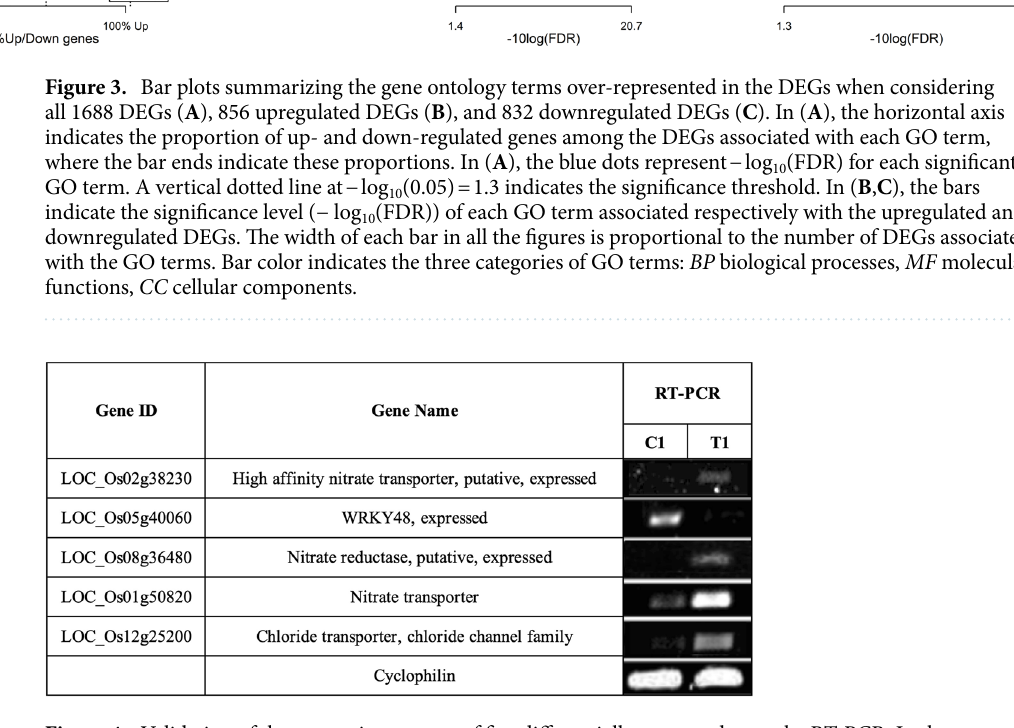
Comparison of DEGs in rice roots during associations with H. seropedicae and A. brasi- lense . Previously, we identified differentially expressed genes in rice roots during associations with Azos- pirillum brasilense 13 . In the rice- A. brasilense study, we analyzed the rice transcriptome 1 dpi with A. brasilense under similar experimental conditions used in the current study. In fact, the libraries from the different rice root samples (mock, H. seropedicae -inoculated, and A. brasilense- inoculated) were all sequenced in the same batch to avoid any possible batch effects when comparing the gene expression patterns in rice roots during associations with these two different PGPB. We identified 628 genes that were differentially expressed during associations with both bacteria (Supplementary Table 6). We performed GO analysis to understand the biological signifi-